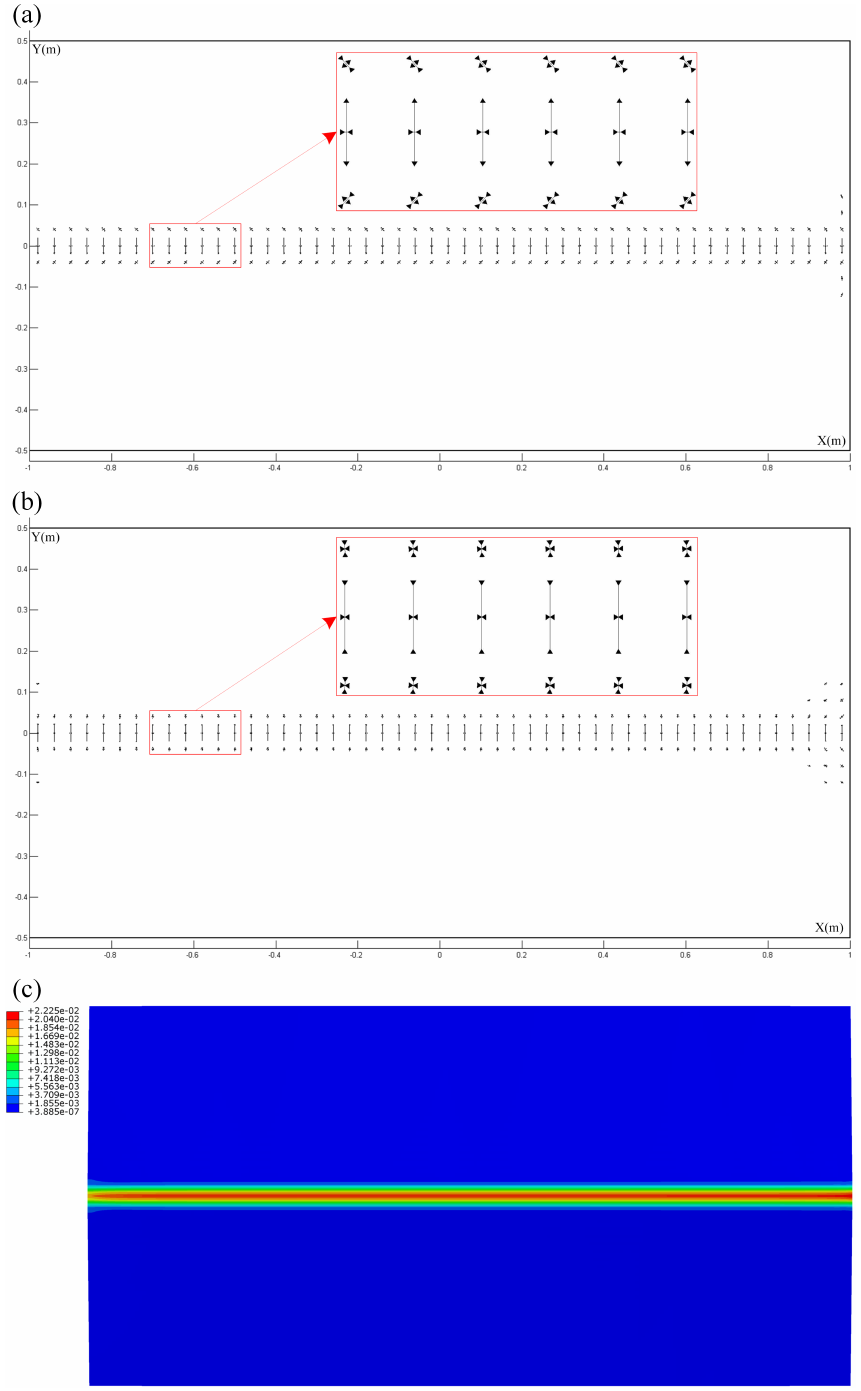
Figure 5. Results of strain distributions. (a) Distribution of in-plane strain (maximum value = 0.003). (b) Distribution of bending strain (maximum value = 0.024). (c) Distribution of maximum principal